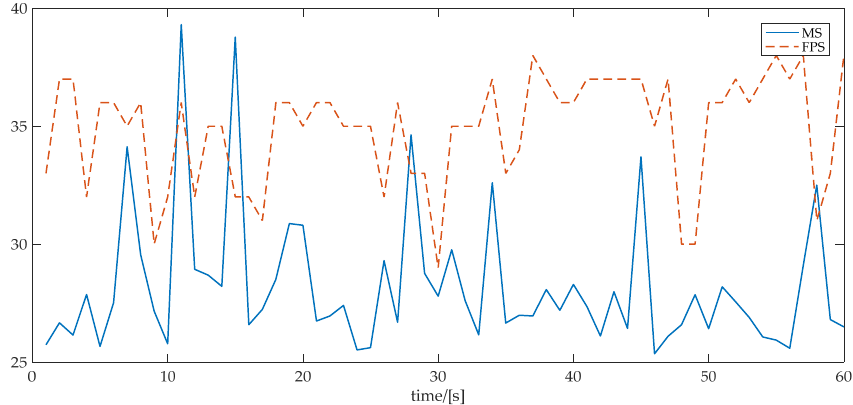
Figure 13. Dynamic fusion of 60 s delay (MS) and frame rate (fps).